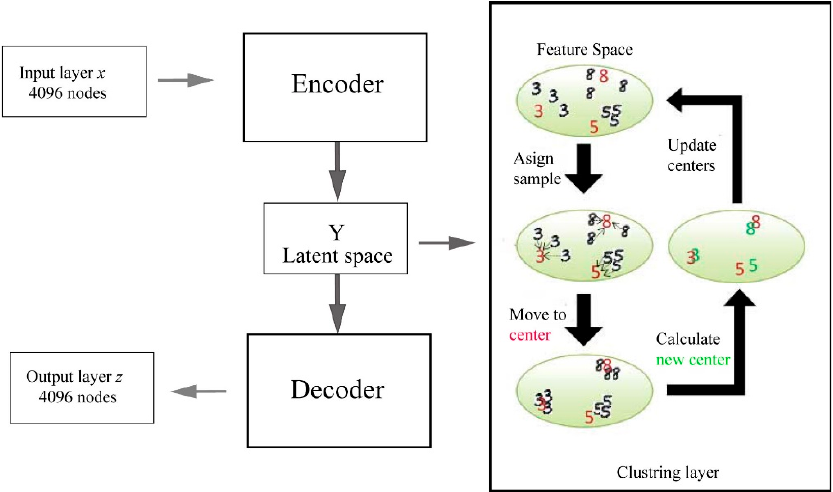
Figure 6. The deep-stacked auto-encoder-based clustering. On the left, data representation is computed using an auto-encoder. On the right, data evolution in the feature space occurs after constraints are imposed on the feature layer. The red numerals represent the former clusters, and the green numerals signify the updated clusters in the feature space.